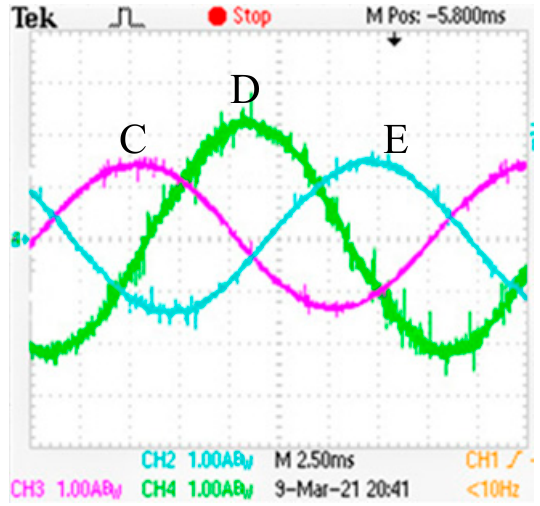
Figure 13. Waveform diagram of the lack of phase A and B current experiment.